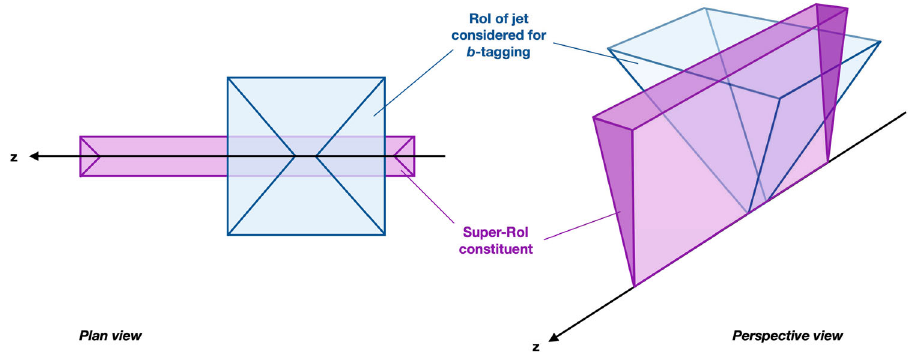
Fig. 3 AschematicillustrationofonejetRoIthatisaconstituentofthe super-RoI (used for the primary-vertex-finding stage of the b -jet trig- ger) and the RoI constructed around a given jet for which the b -tagging algorithms are evaulated, shown in plan view ( x , z plane, left), and in perspective view (right). The beamline is along the z -axis. The first stage of the b -jet trigger constructs a super-RoI from an amalgamation